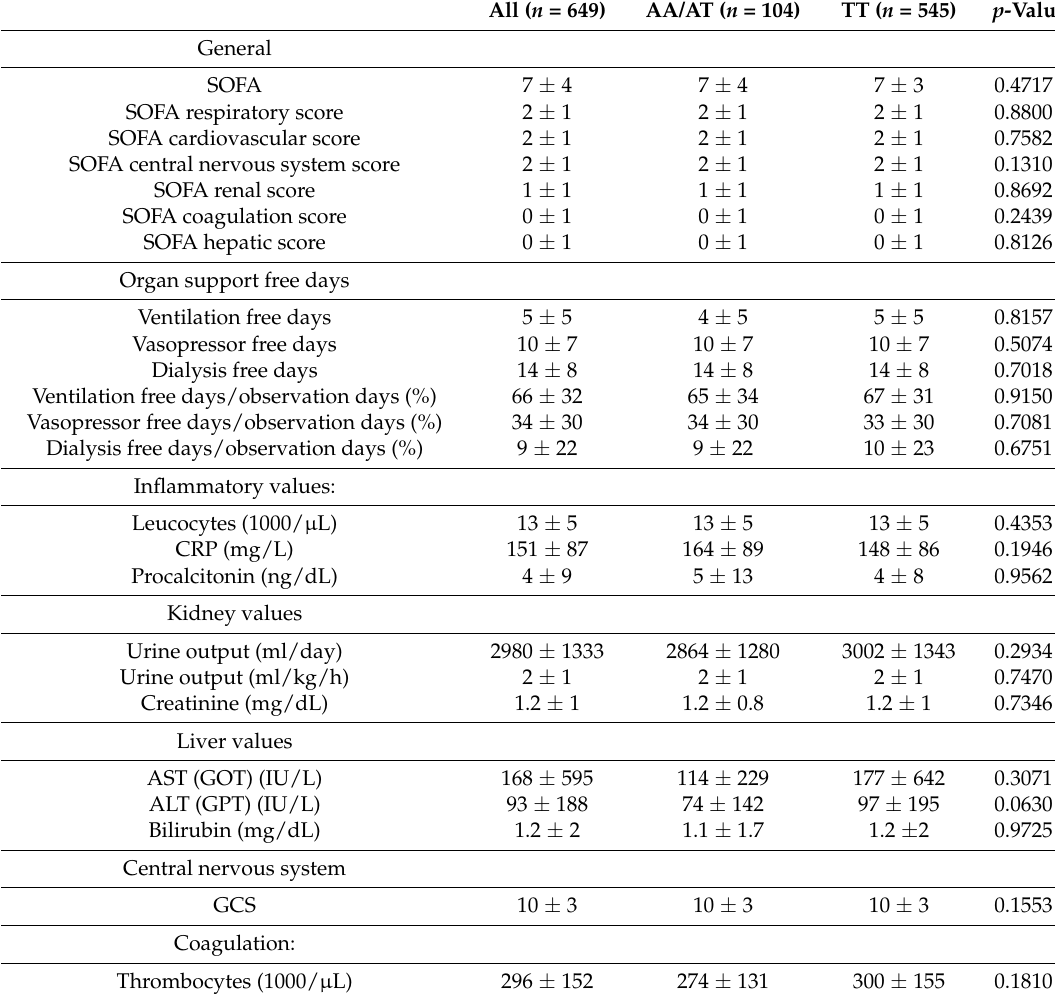
Table 3. Disease severity with regard to TREM-1 rs2234237